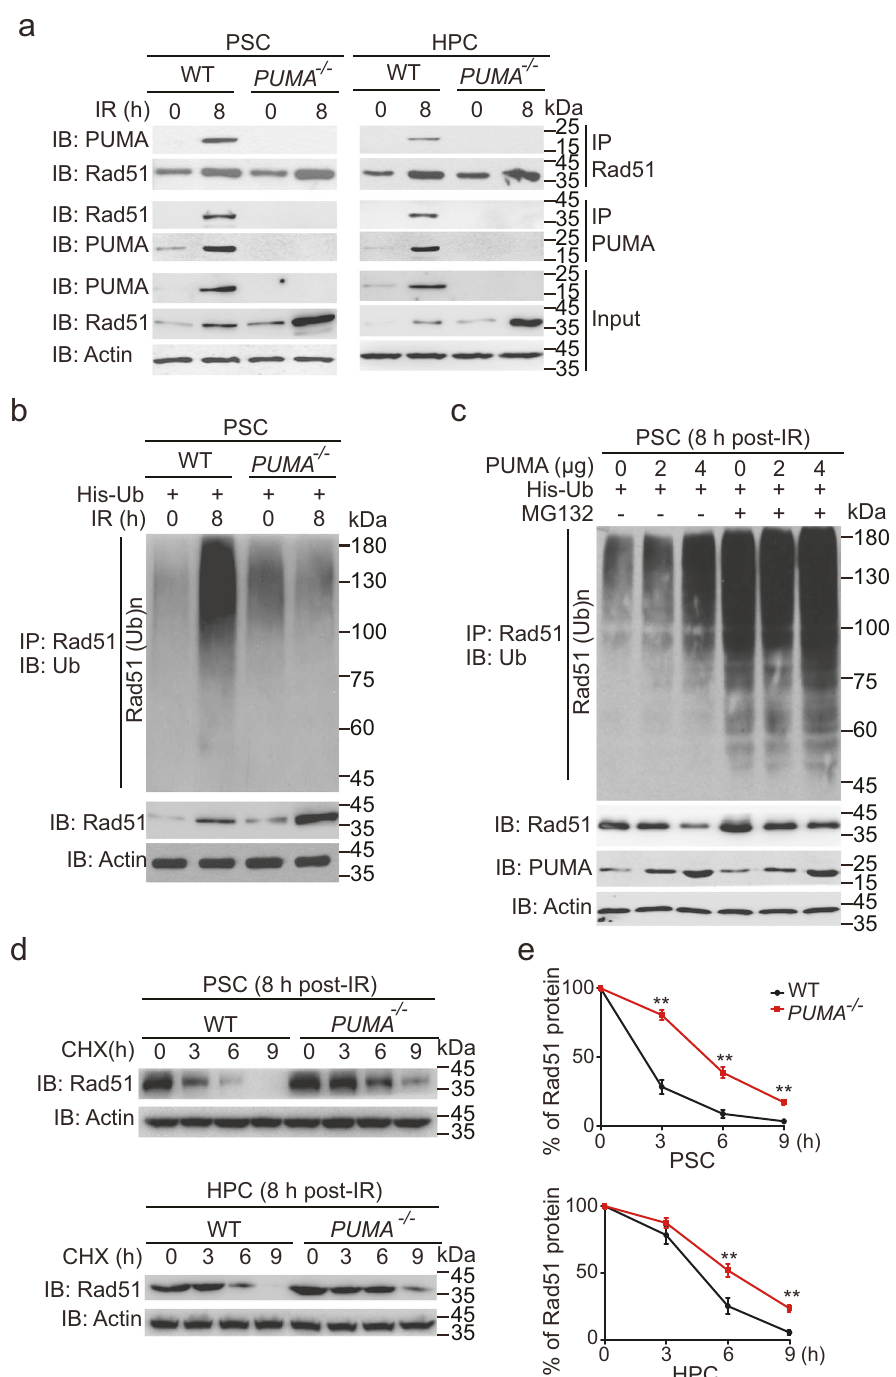
Fig. 3 PUMA binds to cytosolic Rad51 and promotes its ubiquitination and stability. a Immunoprecipitation (IP) and IB of PUMA interaction with Rad51 in PSCs or HPCs. PSC and HPC cells were treated with 2 Gy of IR, and then collected at 0 or 8 h for IP and IB analyses. β -Actin was used as a loading control. b IP and IB of Rad51 ubiquitination in PSCs treated with or without 2 Gy IR. His-tagged Ub was transfected into PUMA KO PSCs, and then cells were lyzed for IP and IB analyses. c Effects of re-expression of PUMA in PUMA KO PSCs on Rad51 ubiquitination. PUMA cDNA (0, 2, or 4 μ g) was transfected into PUMA KO PSCs. At 48h after transfection, cells were treated with or without of 30 μ M MG132 for 4 h. d Effects of PUMA knockout on Rad51 stability. At 8 h after IR, cells were treated with cycloheximide (CHX, 20 mg/ml) for the indicated time points. e Quanti fi cation of Rad51 protein levels in d . Data are representative of three independent experiments with similar results. Error bars, SD. ** P <